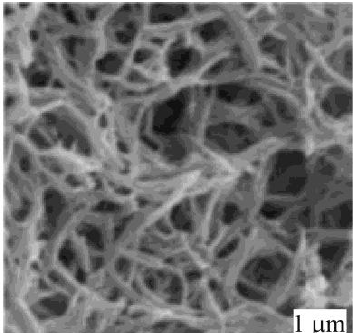
] obtained from Pd(OAc) 2 n